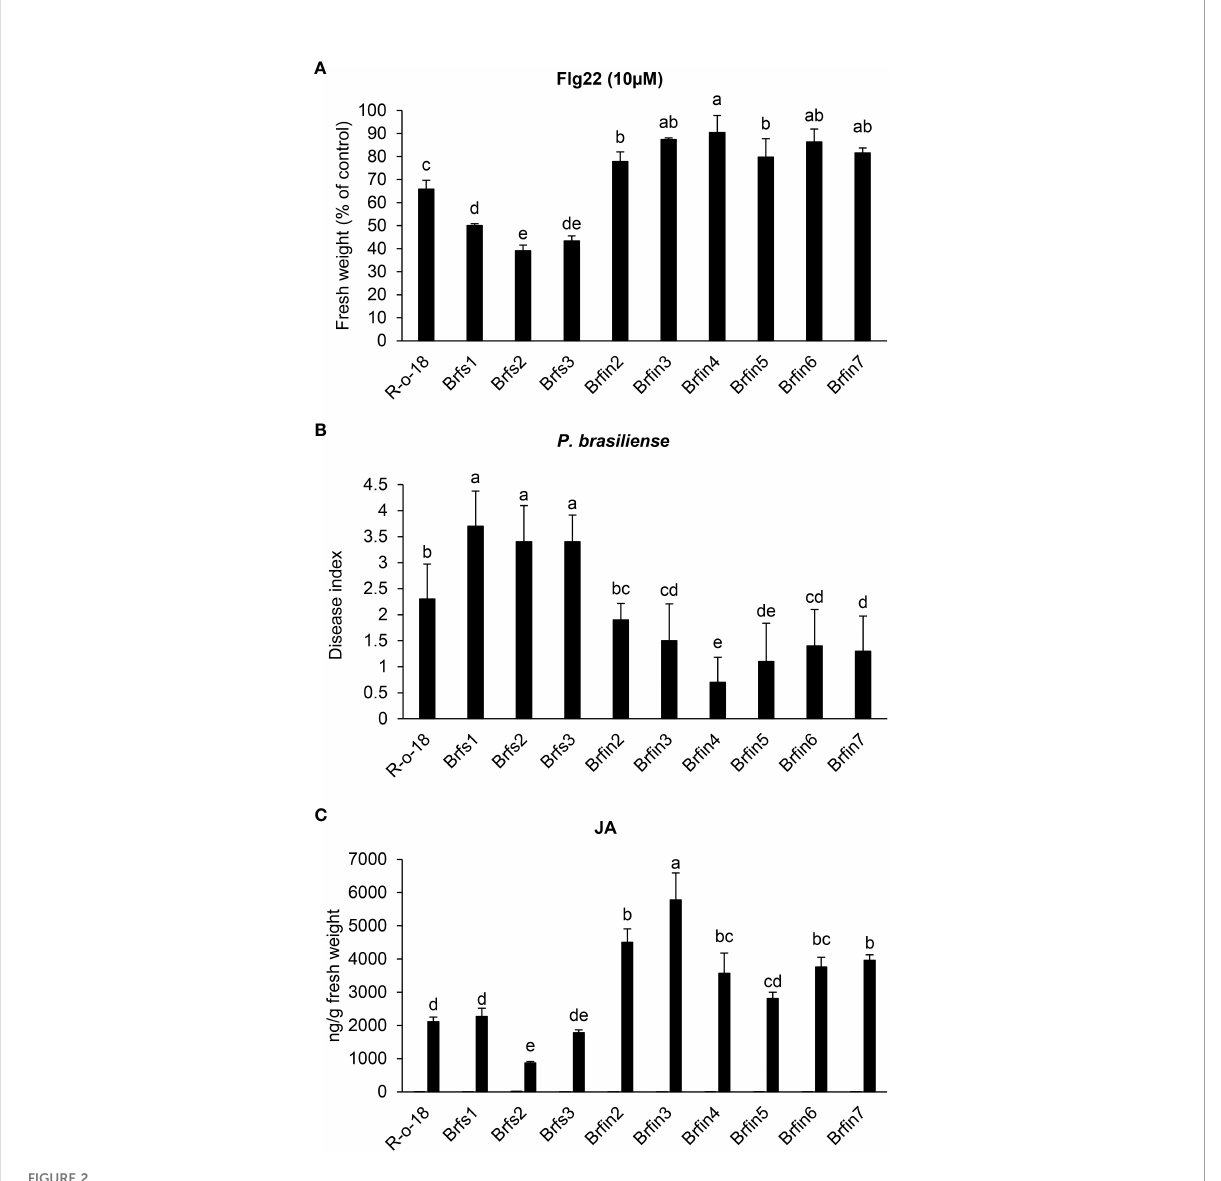
Br fi n lines increased or inhibited other fl g22-induced responses compared to R-o-18. Since MAPK phosphorylation and ROS production are rapid and transient responses associated with two parallel fl g22 signaling pathways, we compared these activities among the selected Br fs and Br fi n lines and R-o-18.